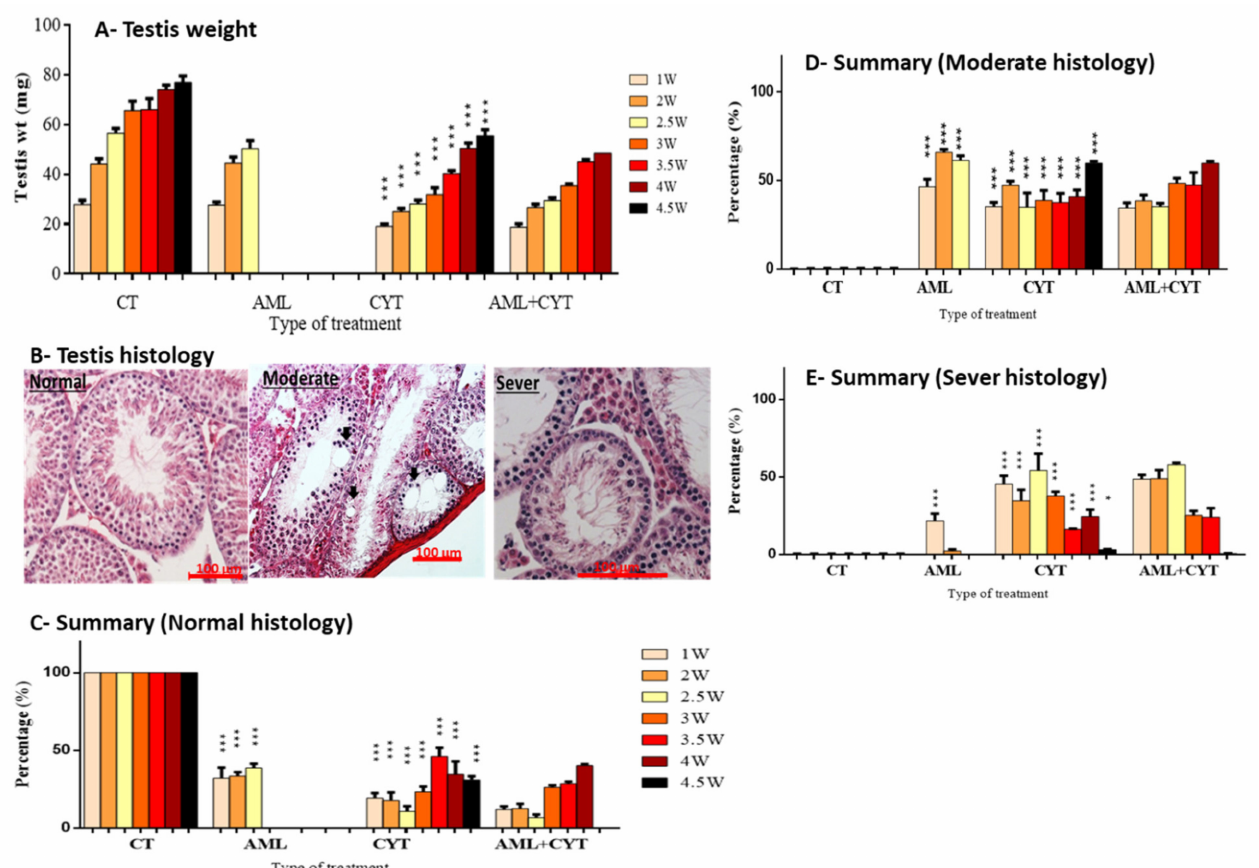
Figure 2. Effect of AML and CYT on testes weight and histology of immature treated mice. Mice were treated as described in Figure 1. Testes weights (mg) were measured at several time points post injection (1–4.5 week) ( A ). Histological sections were isolated from all treated groups at several time points post injection (1–4.5 week). The sections were classified according to severity level into three classes ( B ): percentage of normal seminiferous tubules ( C ), moderate ( D ) and severe ( E ). N = 4; n = 2–12. * ( p < 0.05), *** ( p < 0.005), @ ( p < 0.05), @@ ( p < 0.01) significant relative to AML